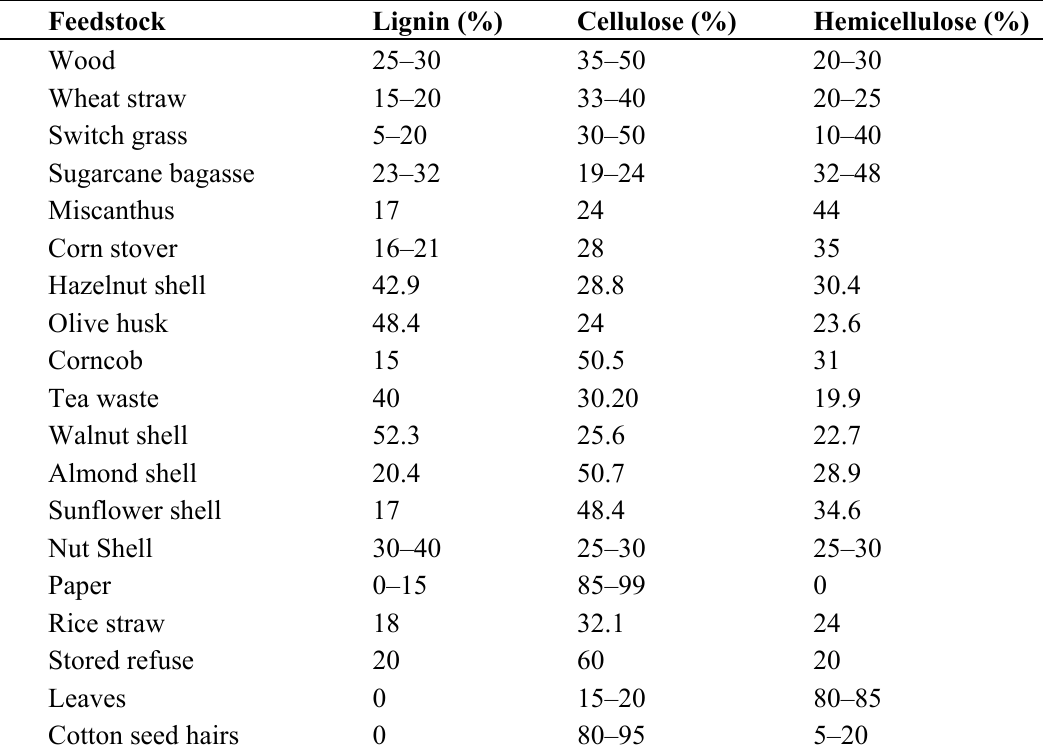
Table 2. Lignin, cellulose and hemicellulose content of selected biomass